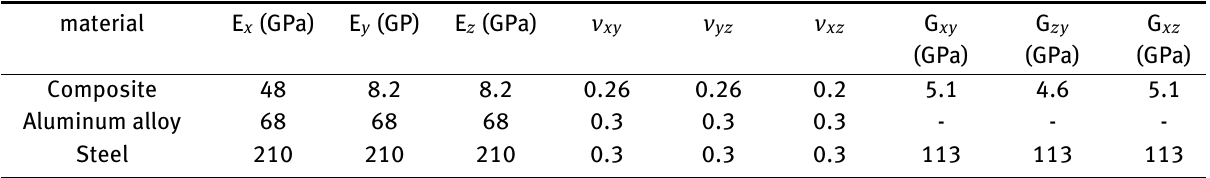
Table 1: Material properties of test specimens material